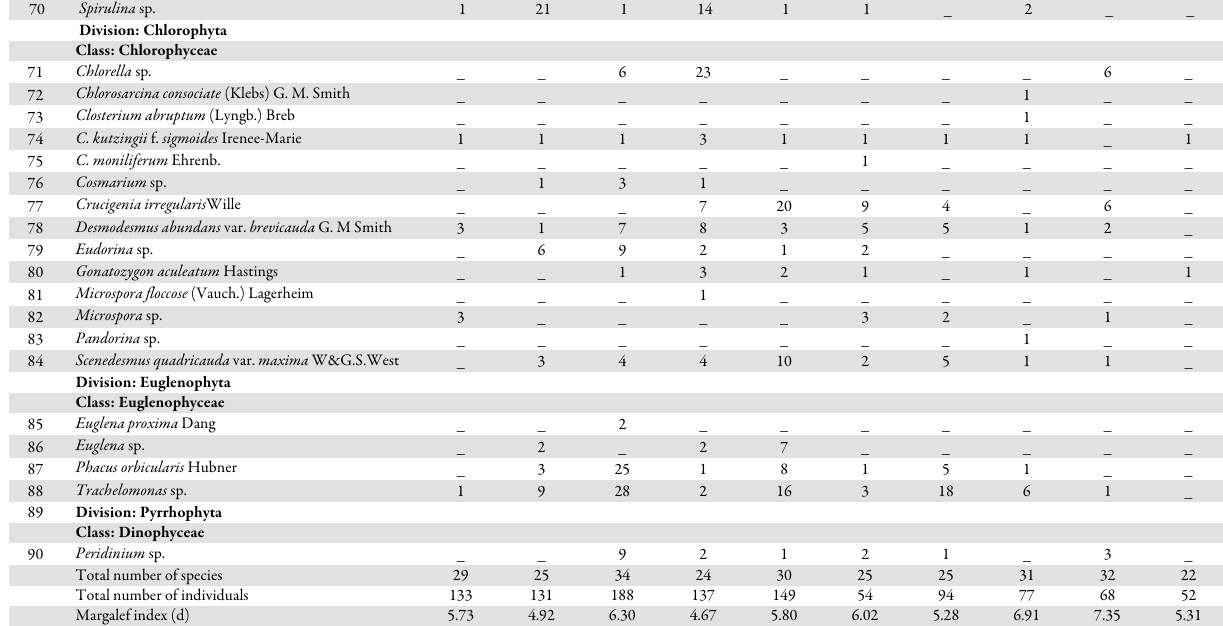
Table 4. Zooplankton composition and abundance at Ibefun River (Ogun state) during sampling period Microalge composition